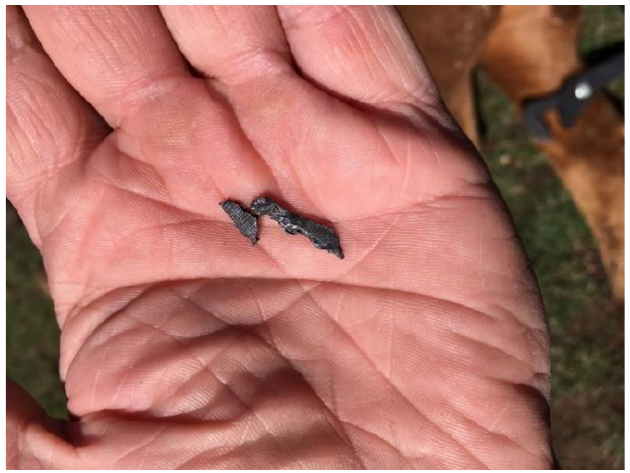
Figure 2. Pieces of lead removed from rumen of necropsied heifer.